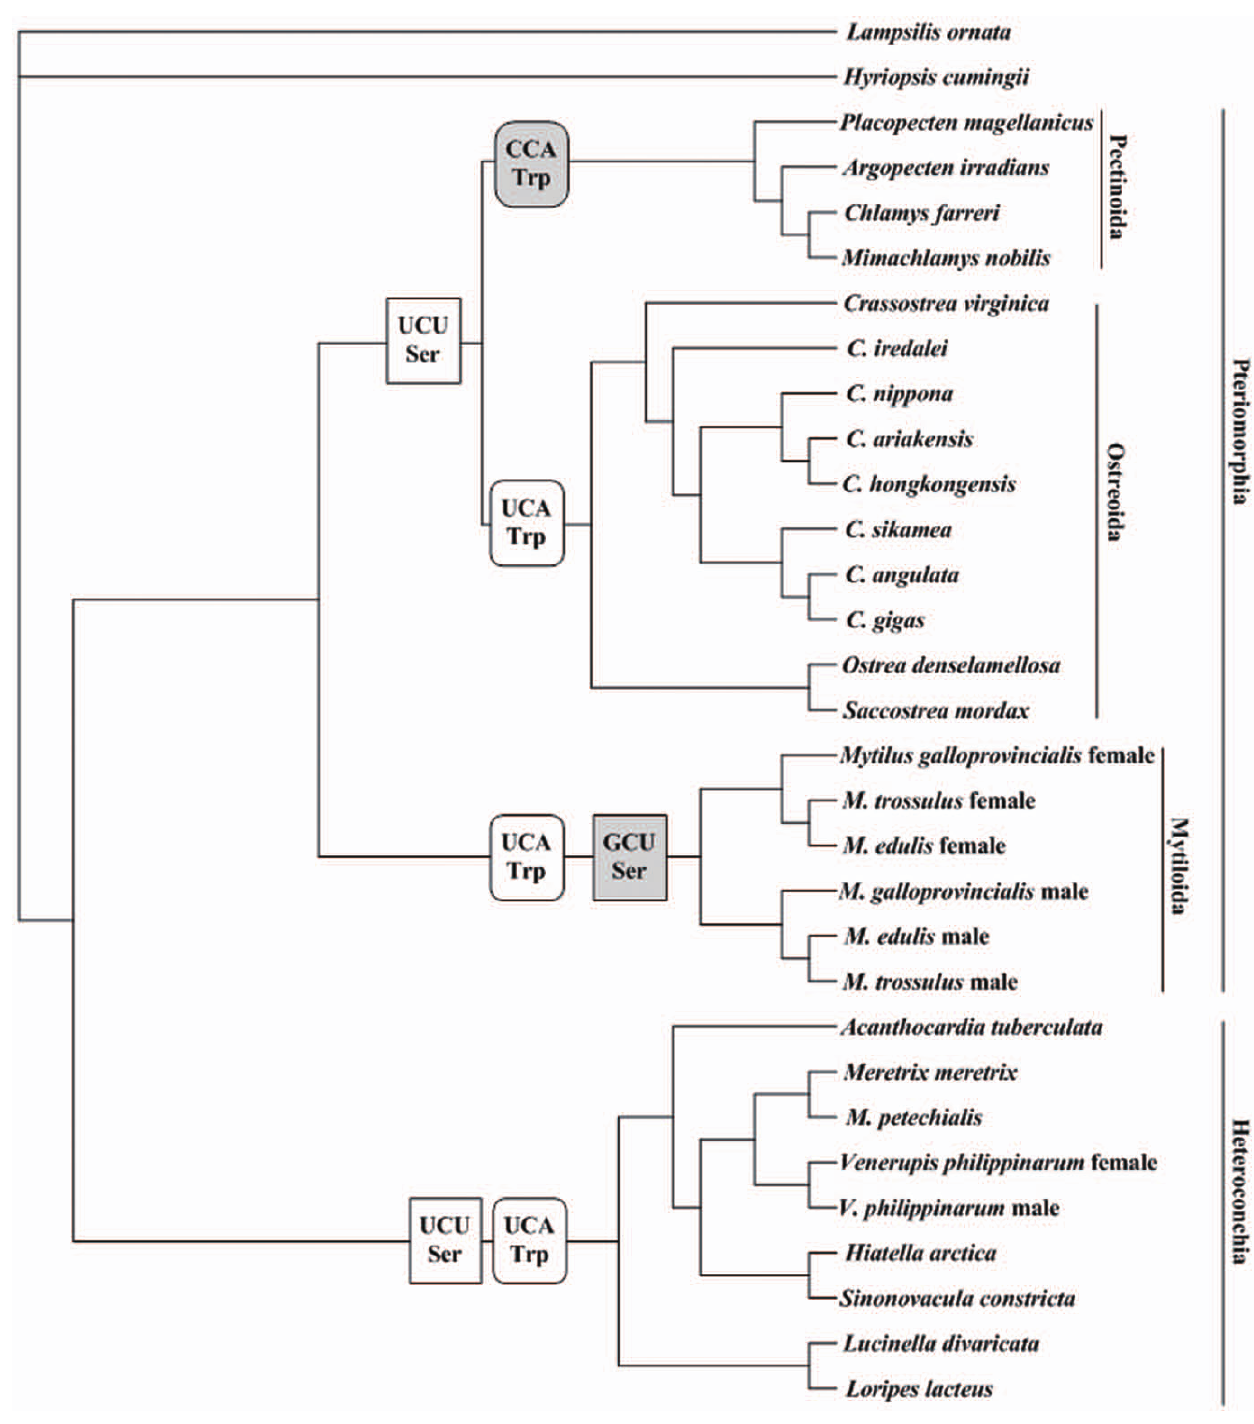
Figure 1. Evolution of the tRNA anticodons in marine bivalve mitochondrial genomes. The relationship presented is based on concatenated nucleotide sequences of 12 protein-coding genes by Bayesian inference analysis. Letters in gray text boxes demonstrate unusual anticodons that deviate from the usual anticodons in most marine bivalves. doi:10.1371/journal.pone.0016147.g001 one clade, the usage of codon UGG is different between the two orders. The usage of UGG is more frequent in the codon UGR family in Pectinoida, whereas it decreases in Ostreoida (Supporting Information Table S1). We refer that a mutation C at the wobble